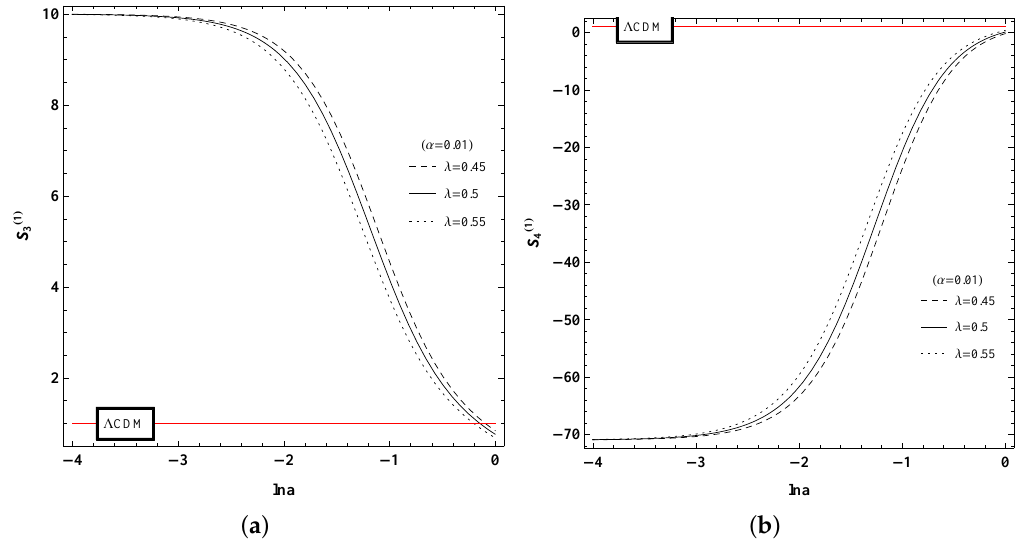
( 1 ) for P 1 with different parameters λ and fixed α = 0.01. ( b ) Graph of S 3